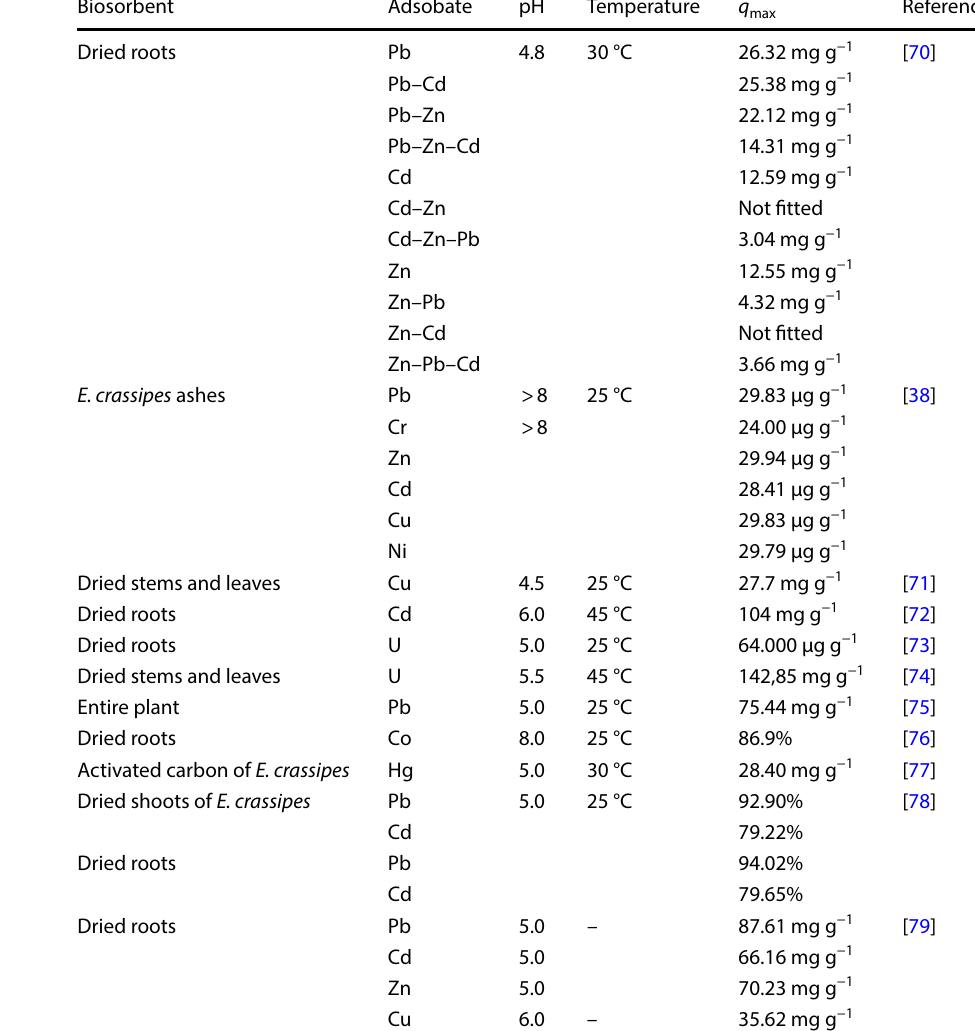
Table 6 The adsorption capacity of metals by Eichhornia crassipes and its respective operational